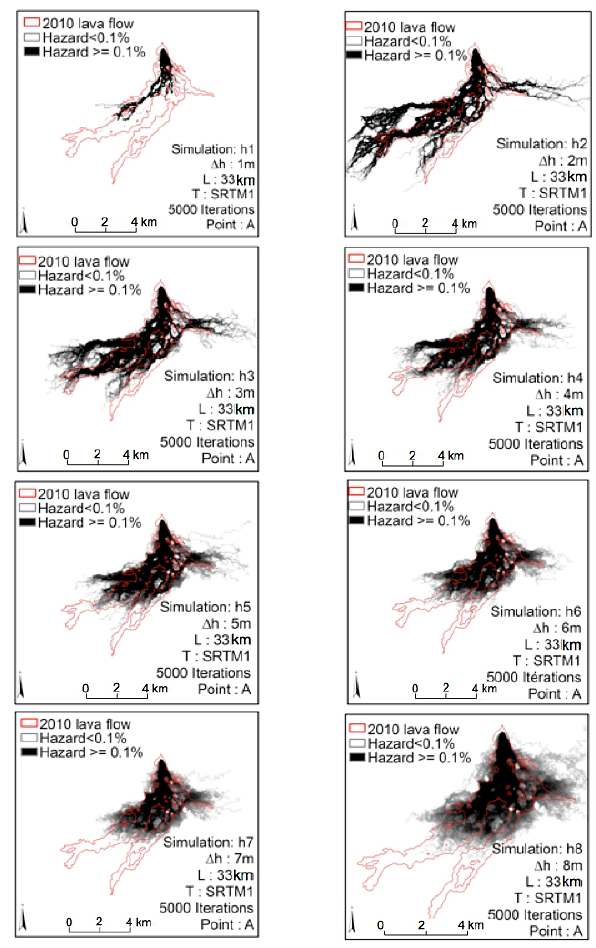
Figure 6. Simulations considering different values of height cor- rection ( (cid:49)h) (average lava flow thickness). Increasing the lava flow thickness from 1 to 3m increases the maximum distance reached by the lava flow. Increasing it further up to 8m reduces the maximum distance reached by the lava flow but increases the surface covered by the simulated lava flow. This widening effect of the simulated flow is due to the fact that thicker flow can run over higher topog- raphy. As the path length is fixed at 33km for all simulations, the runout distance of the simulated lava flow may consequently de- crease for higher (cid:49)h if the topography is such that the lava flow may spread laterally, as it happens in the case simulated here. The result that best fits the 2010 lava flow is h3, which corresponds to a lava thickness of